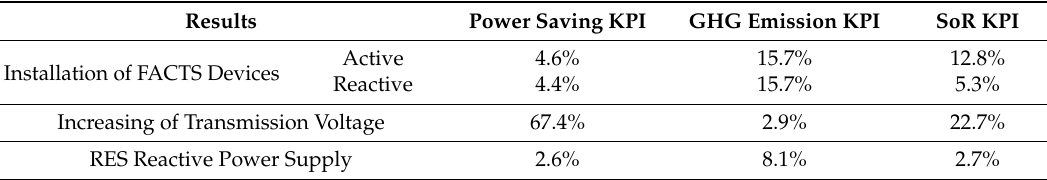
Table 12. Result summary for the KPIs’